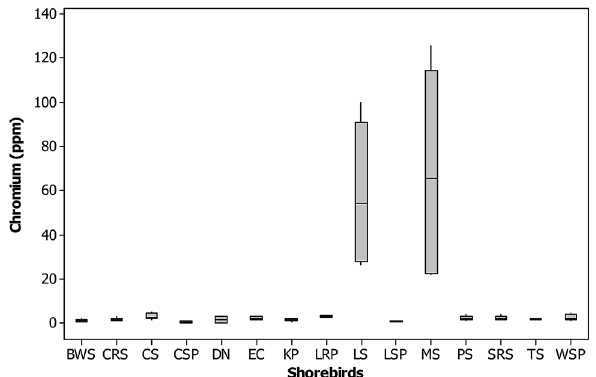
Figure 4. Box plot showing the concentration of chromium (ppm) recorded in different shorebird species at Point Calimere Wildlie Sanctuary, Kodikkarai and Pichavaram Mangrove Forest, Pichavaram, east coast of Tamil Nadu, India.